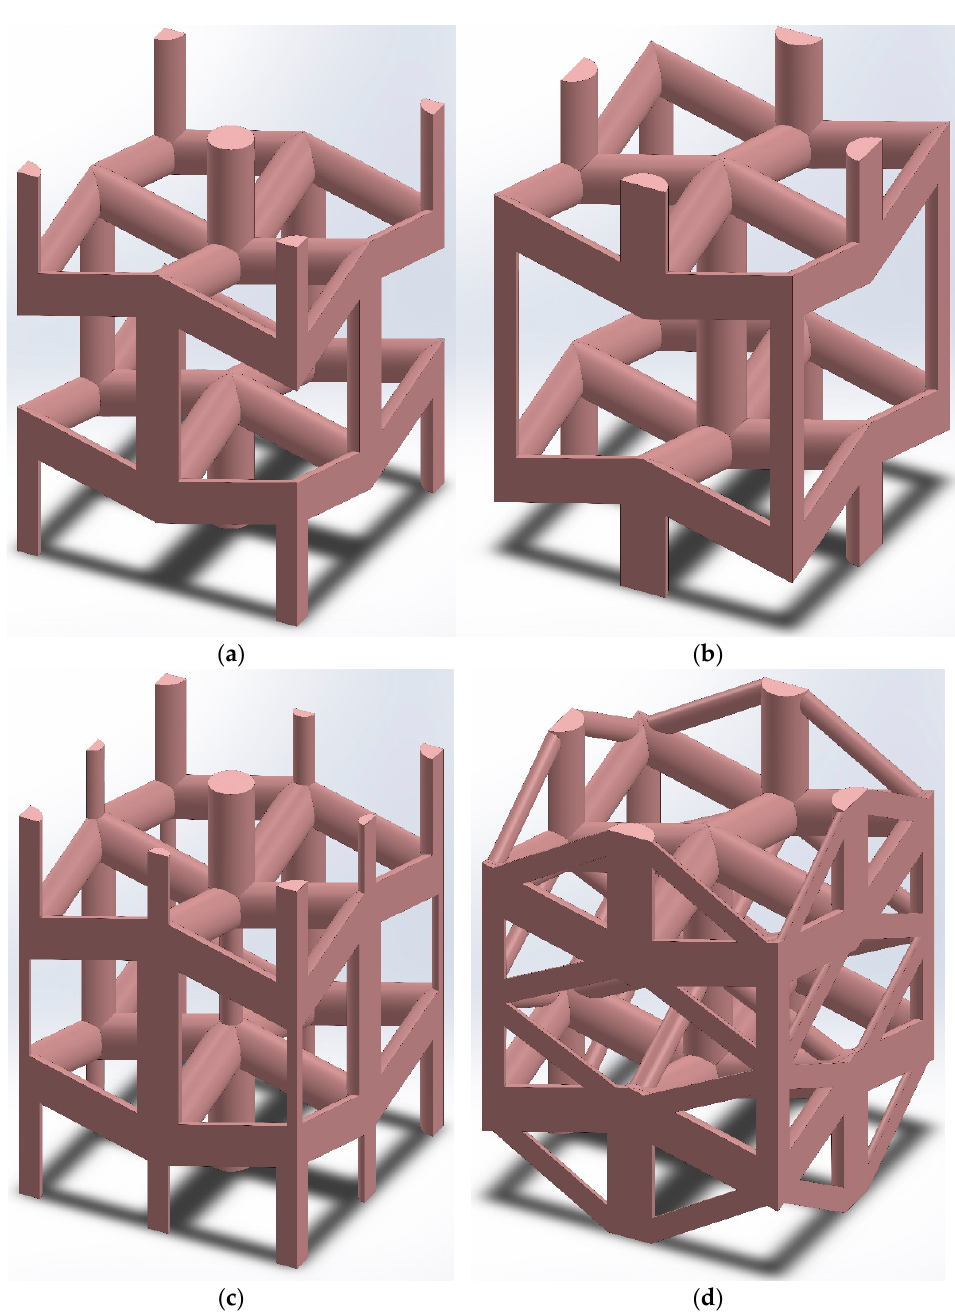
Figure 1. Review of 3D re-entrant unit cells presented by ( a ) Li Yang et al. (2015) [50], ( b ) Xin-Tao Wang et al. (2016) [51], ( c ) Yu Chen et al. (2017) [52], and ( d ) Yingying Xue et al. (2020) [53].